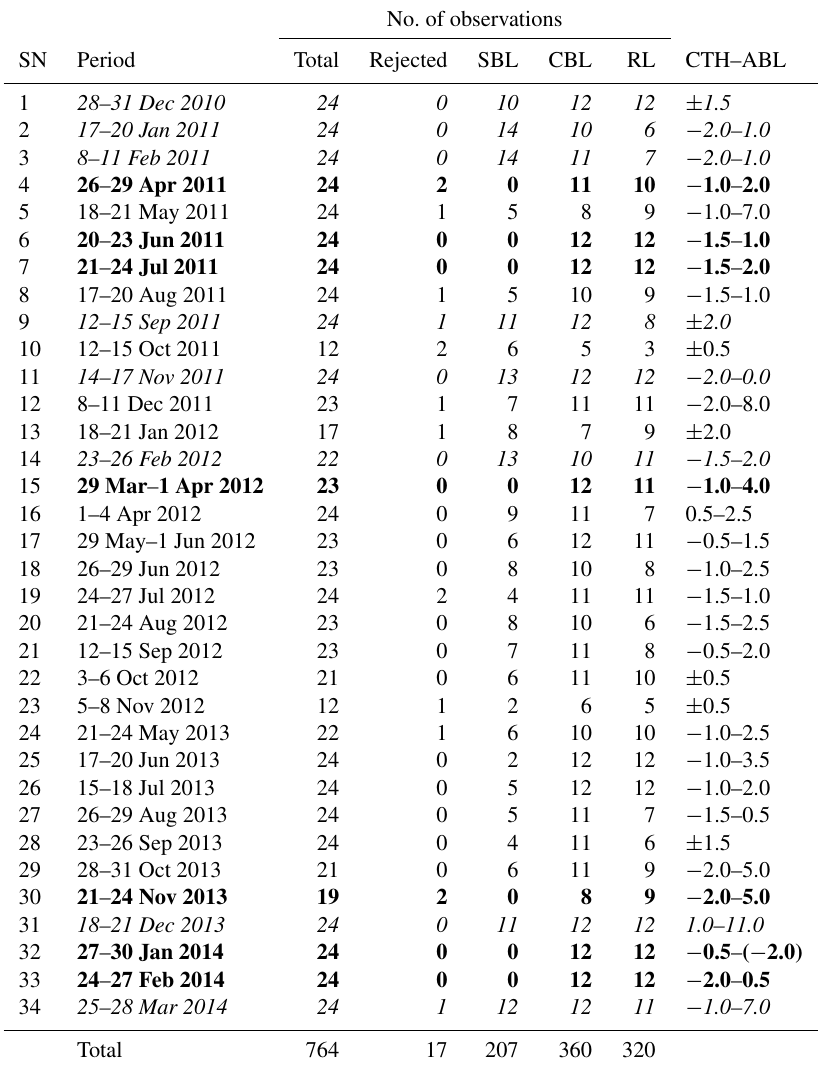
Table 1. List of 3-day campaigns conducted during the period December 2010–March 2014. Total number of observations, rejection of bad quality data, the SBL, the CBL, and the RL are listed for each campaign. Shaded regions with italic fonts indicate campaigns with more than 90% of the SBL defined. Bold indicates those campaigns where SBL is not defined and the rest when the SBL occur intermittently. Cloud top temperature (CTH) relative to ABL are also